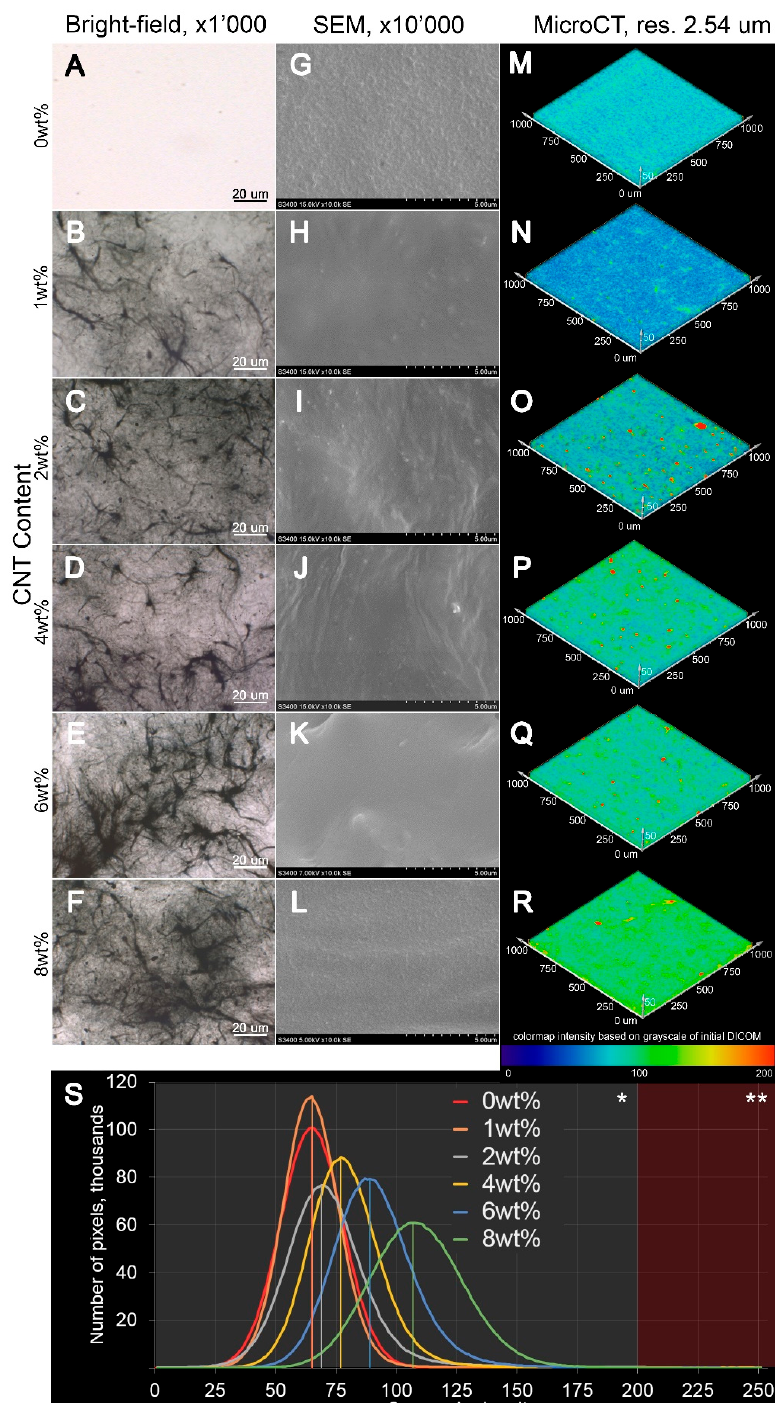
Figure 4. (A – L) . Representative images of the intact and CNT-modified SIBS films acquired using Figure 4. ( A – L ). Representative images of the intact and CNT-modified SIBS films acquired